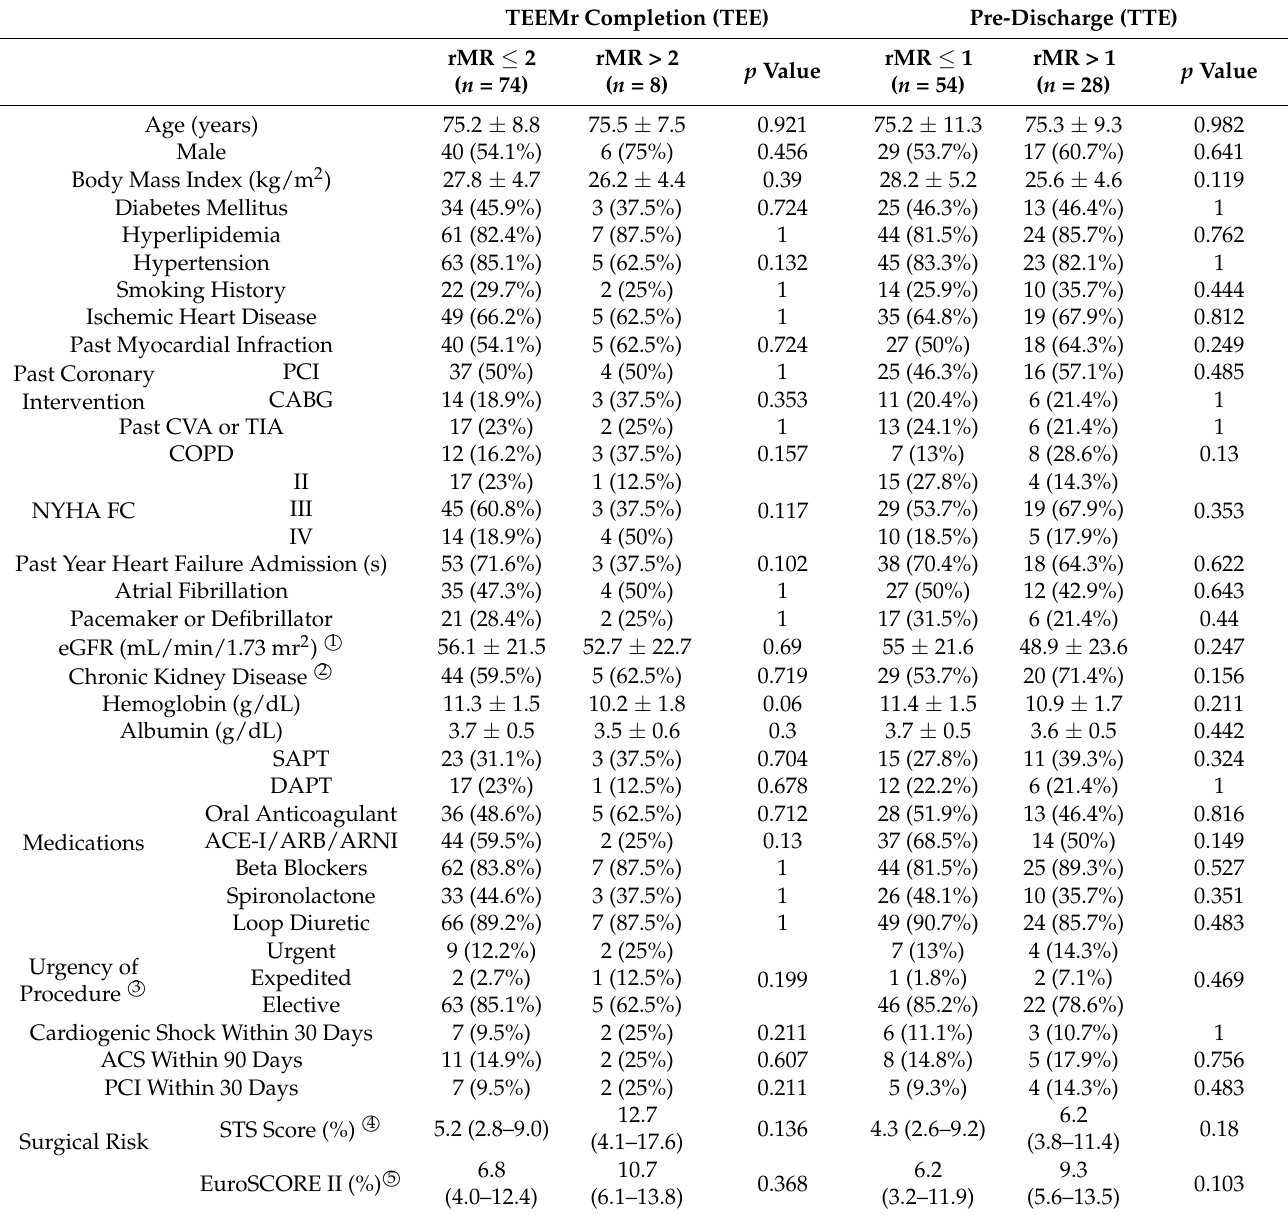
Table 1. Baseline clinical